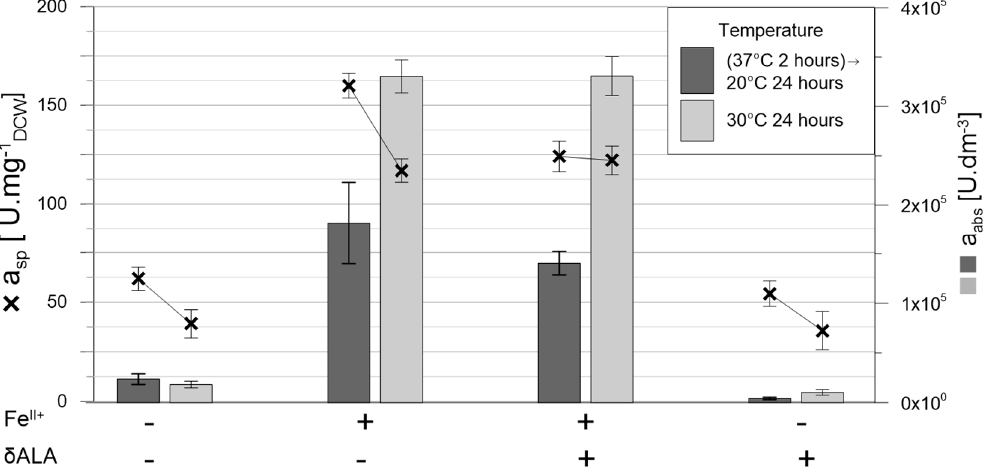
Figure 5. Specific activity of E. coli JM109(DE3) expressing HPL and absolute activity produced per liter of culture media with combination additions of 1 mM of δ‐ ALA and 1 mM of Fe II+.